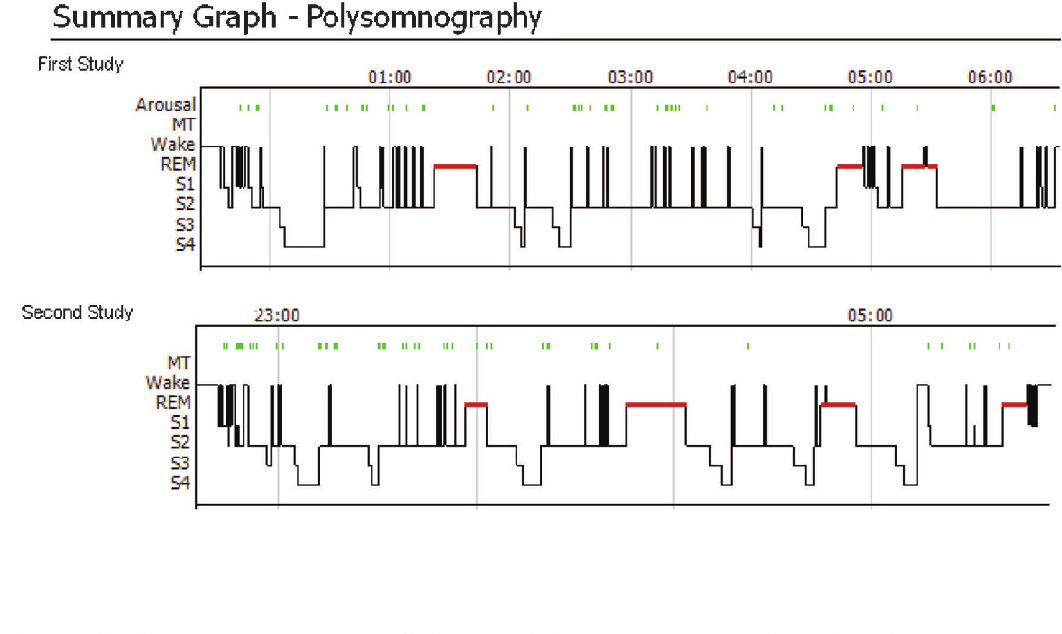
Figure 2 - Differences in the hypnogram prior to and following psychological treatment